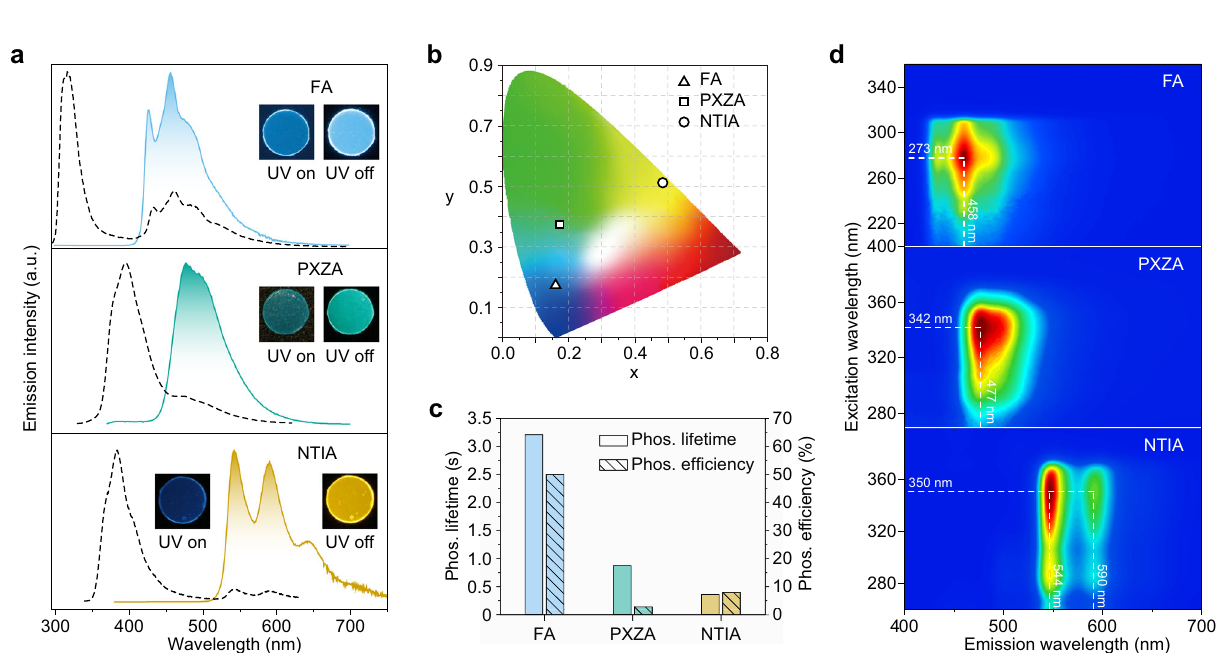
Fig. 3 | Mechanism investigation of ultralong phosphorescence in the emitter doped fi lm. a Normalized phosphorescence spectra of EtCz in PVA fi lm under ambient conditions (top) and in m -THF (1×10 − 5 M) at 77K (bottom). b Phosphorescence lifetimes and ef fi ciencies of CzA and EtCz in PVA fi lms. c 1 H